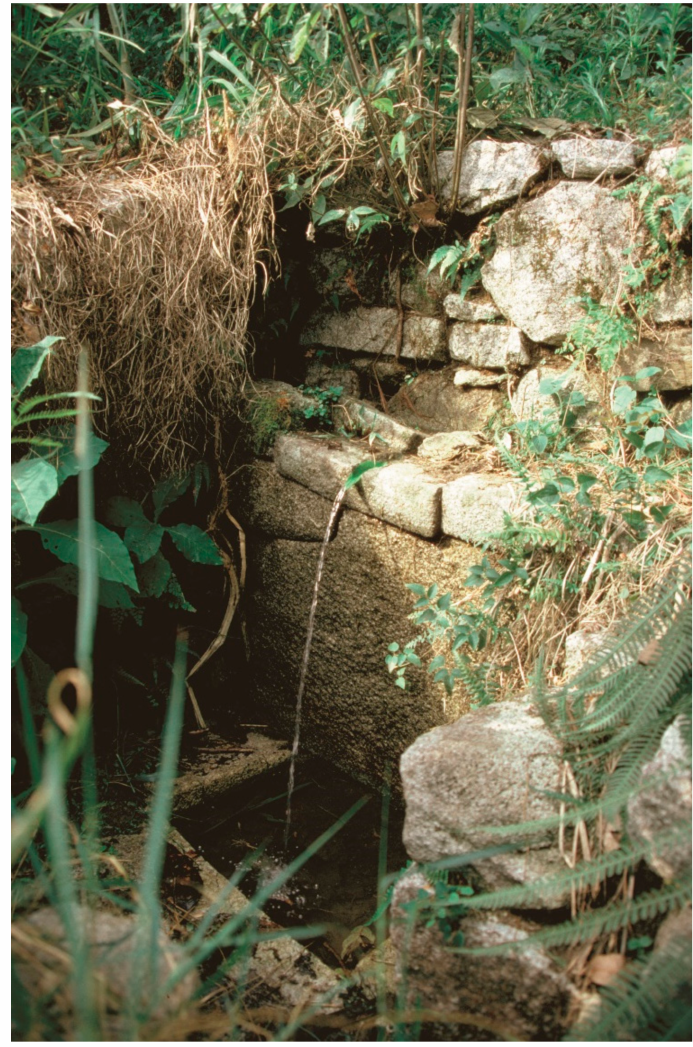
Figure 11. This long-buried fountain along the Inca Trail still operated after centuries of neglect. This photograph was taken a year after it was uncovered during East Flank trail